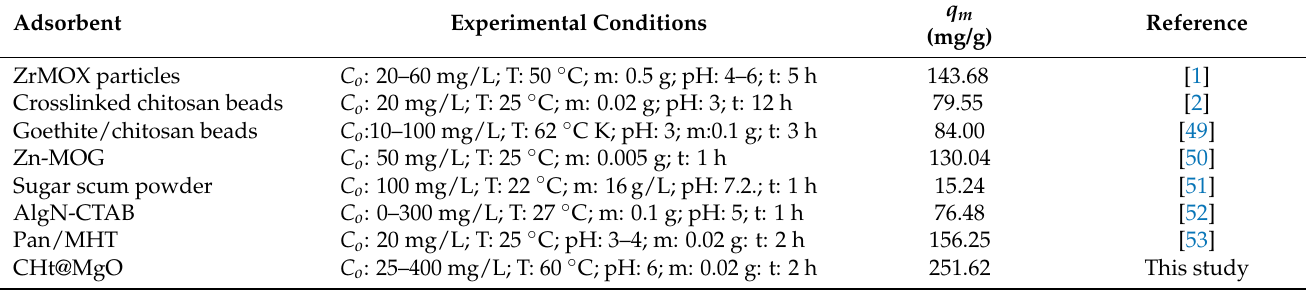
Table 2. Comparison of MO adsorption performance on CHt@MgO with other adsorbents in the